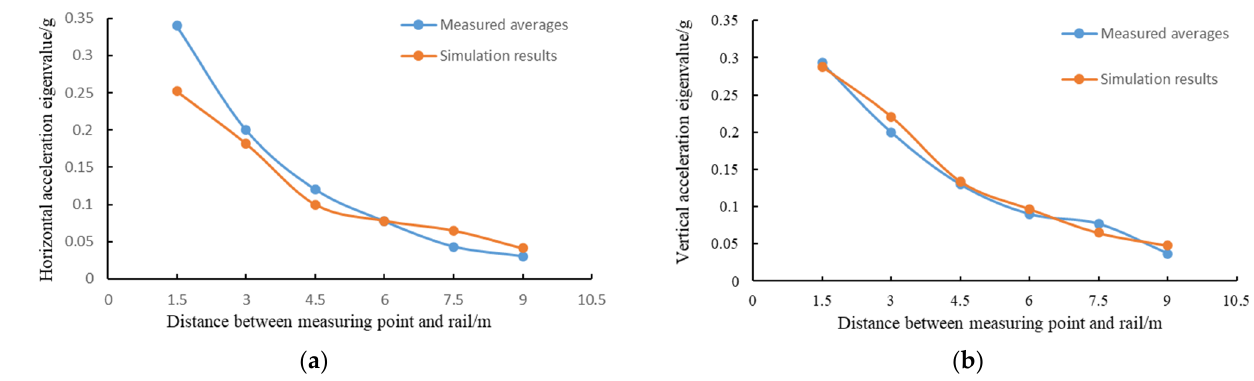
Figure 12. Comparison of acceleration simulation of measuring points above the injection shaft and measured results. ( a ) Comparison of horizontal acceleration simulation of measuring points above the injection shaft and measured results; ( b ) comparison of vertical acceleration simulation of measuring points above the injection shaft and measured results.